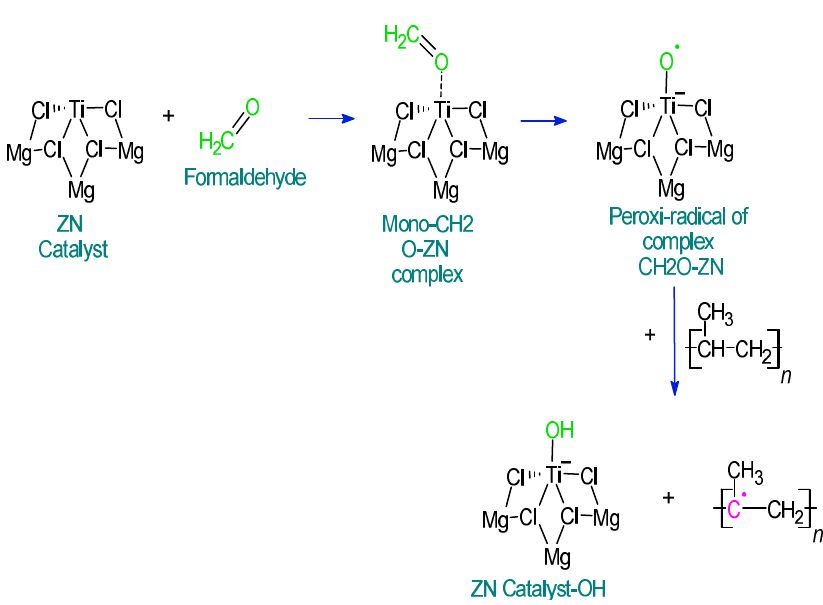
Figure 3. Effect of formaldehyde, propionaldehyde, and butyraldehyde traces on the efficiency of the synthesis of the copolymer.